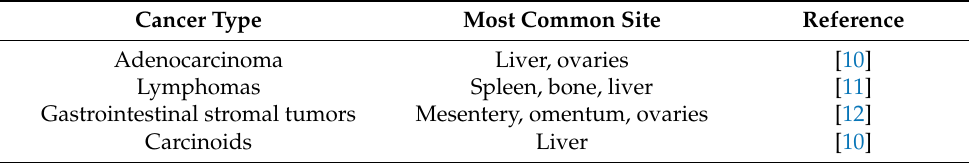
Table 1. Gastric neoplasia subtypes listed with their most common metastasis